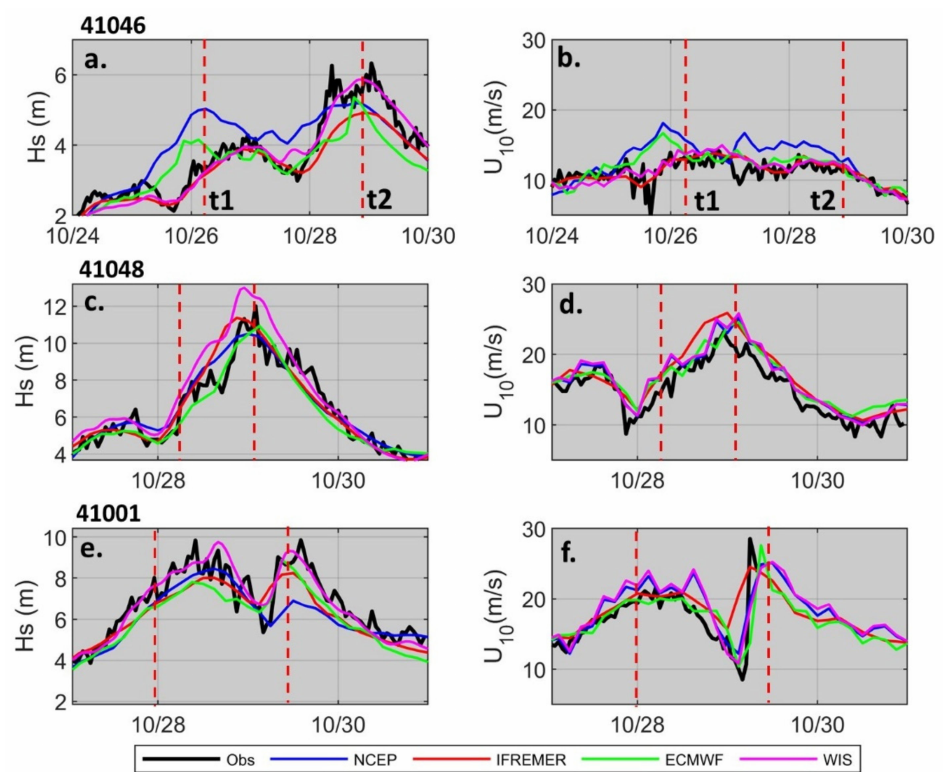
Figure 8. Buoy-model time-series comparisons of ( a , c , e ) Hs and ( b , d , f ) model wind input for buoys ( a , b ) 41046, ( c , d ) 41048, ( e , f ) 41001 during Hurricane Sandy. Red dotted vertical lines denote the times used to assess the 1D wave spectra in Figure 9 (t1,